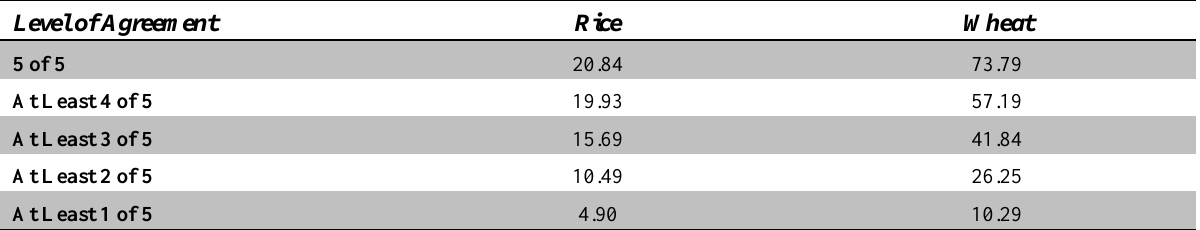
Table 7. MODIS 250 m median crop probability for countries with 60% or more of cropland area in rice, or wheat as a function of function of heritage global cropland map agreement.